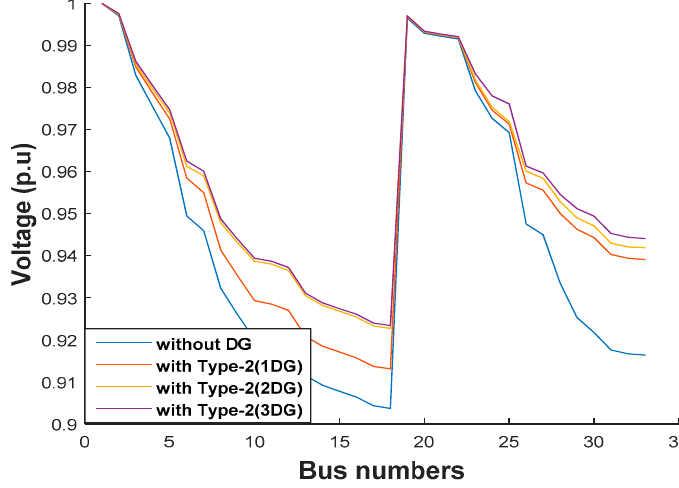
Figure 8. Voltage profile for 33 bus with Type-2 DG for 1st objective function.